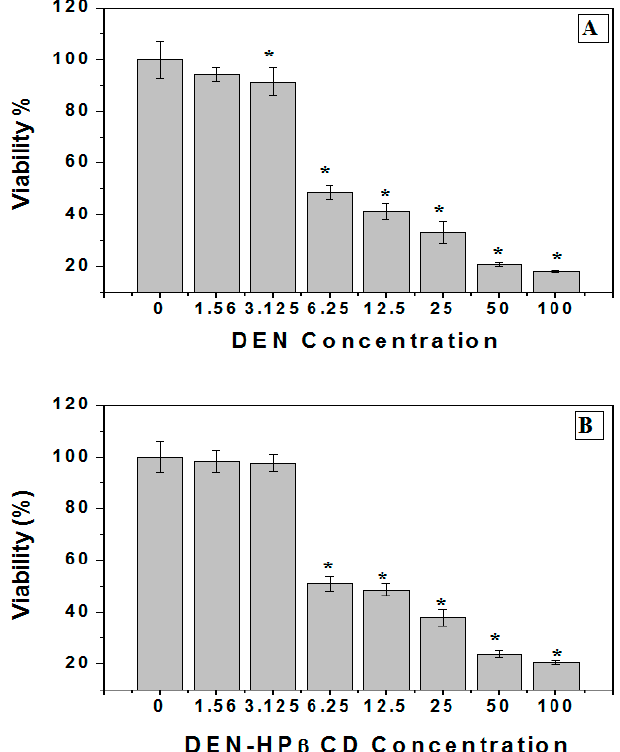
Figure 1. ( A ) Cytotoxicity of DEN (Dentatin) against human colon cancer cells (HT29). The cells were plated in 96-well plates and then exposed to 100, 50, 25, 6.25, 3.125 and 1.25 µg/mL of DEN for 72